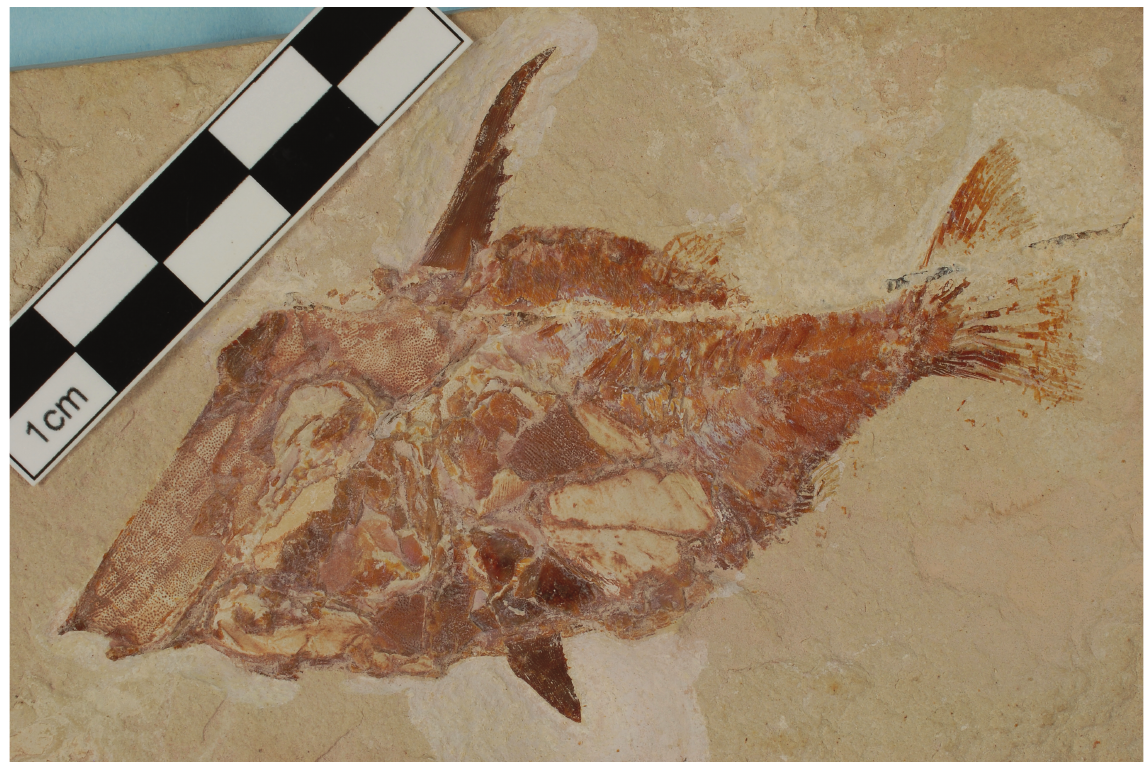
Fig. 12. Joinvillichthys kriweti gen. et sp. nov. Holotype, CLC